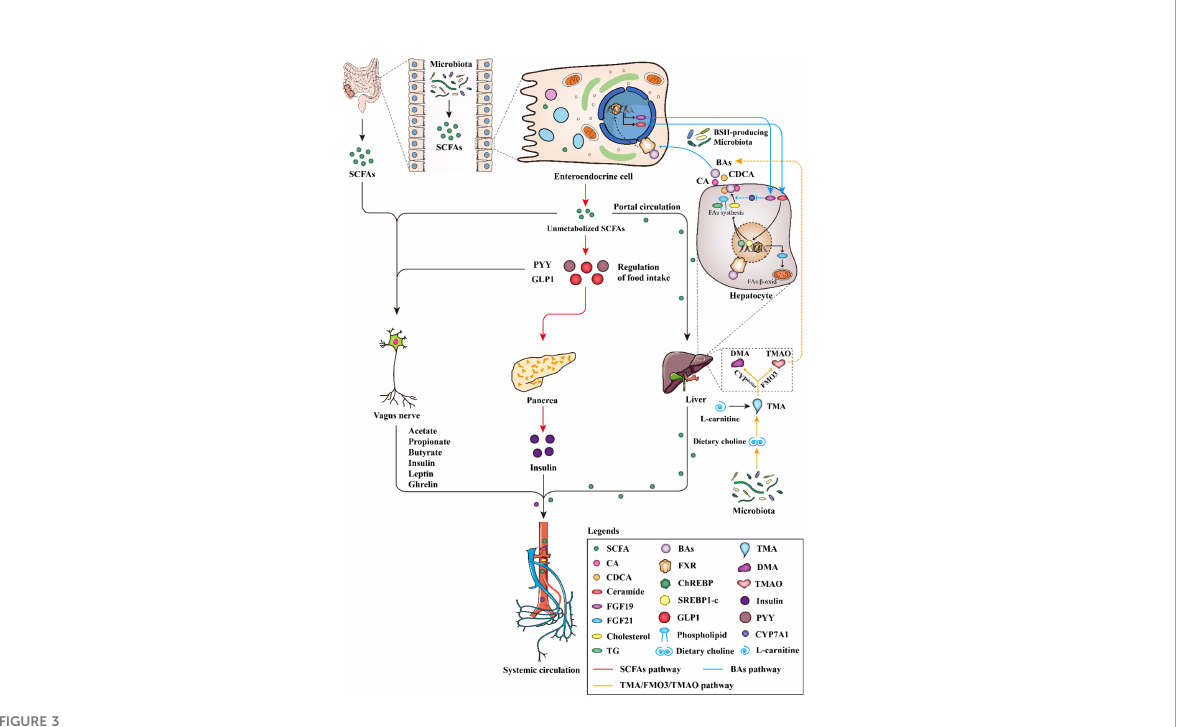
FIGURE 3 The gut microbiota regulates the pathway of